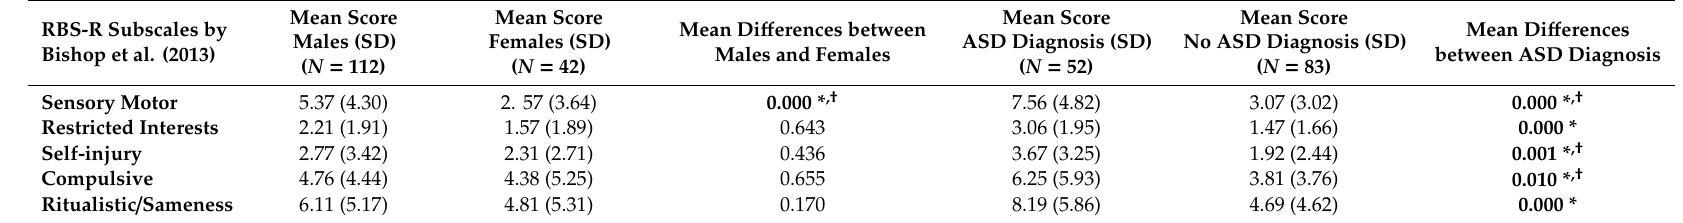
Table 4. Repetitive Behavior Scale-Revised (RBS-R) subscale means by overall sample, gender, and ASD diagnostic status according to Bishop et al.’s (2013) 5-factor